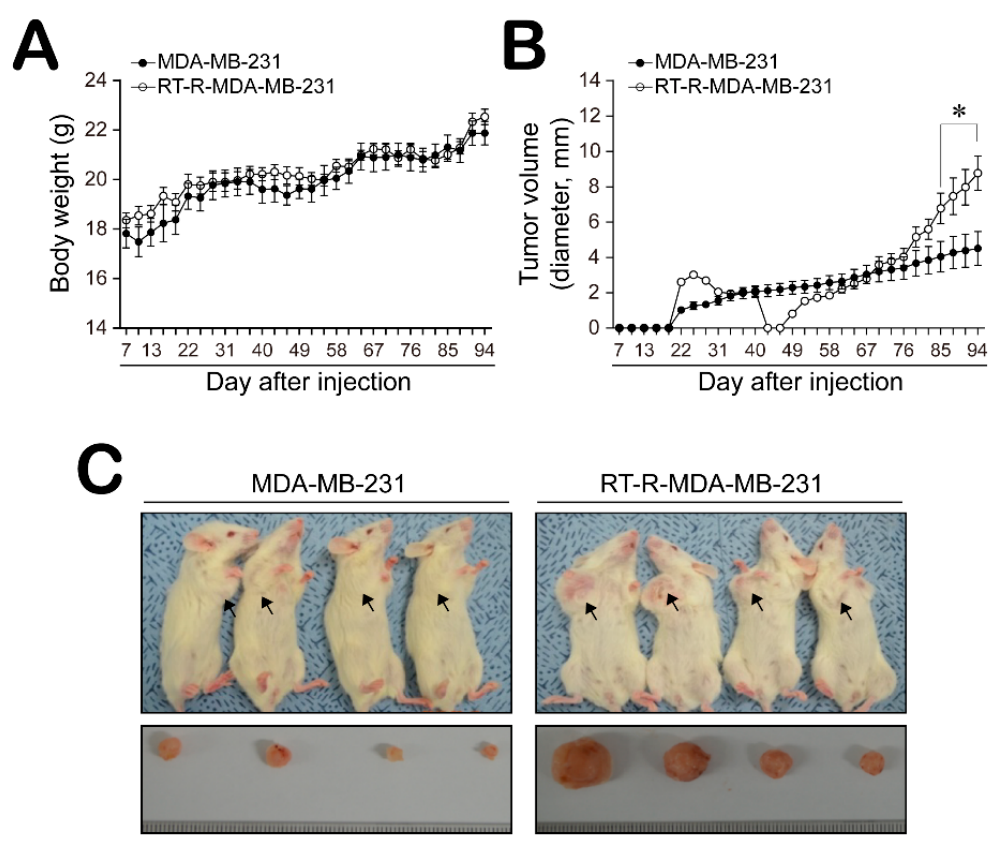
Figure 3. RT-R-MDA-MB-231 cells promoted tumor growth in an in vivo mouse model. Female non obese diabetic-severe combined immunodeficiency (NOD-SCID)mice were divided into two groups and injected subcutaneously into the mammary fat pad with MDA-MB-231 cells and RT-R-MDA-MB-231 cells (5 × 10 6 cells / 100 µ L of serum-free medium), respectively. Body weights ( A ) and tumor volumes ( B ) were measured every 3 days during tumor development. MDA-MB-231-injected or RT-R-MDA-MB-231-injected animals were sacrificed at day 90 after injection, and the tumors were extracted ( C ) (* p < 0.05, compared between MDA-MB-231- and RT-R-MDA-MB-231-injected groups).